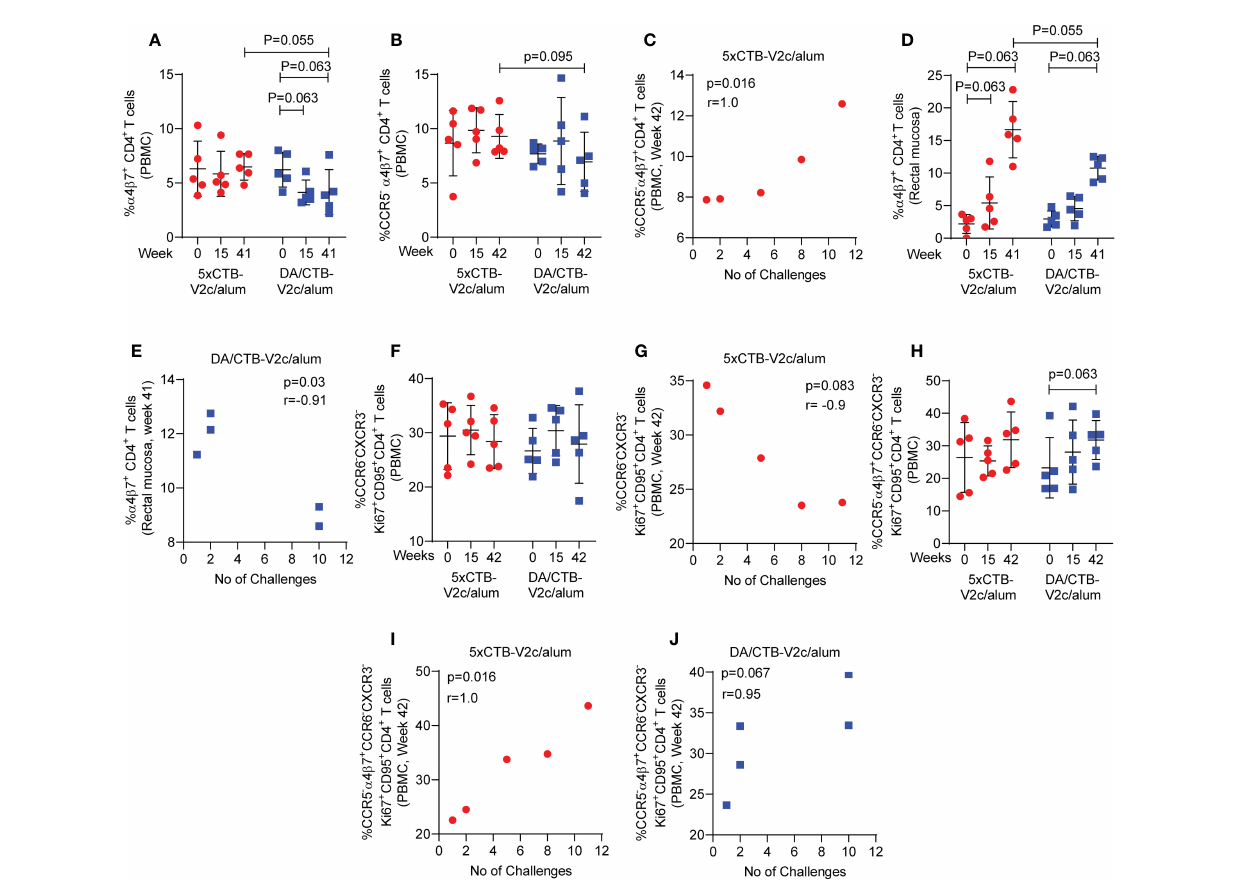
FIGURE 5 Comparison of different T cell subsets and their association with SIV acquisition. Comparison of the frequency of circulating (A) a 4 b 7+ CD4 + T cells and (B) CCR5 - a 4 b 7+ CD4 + T cells over the course of vaccination. (C) Correlation of circulating CCR5 - a 4 b 7+ CD4 + T cells with number of challenges in the 5xCTB-V2c/alum group. (D) Comparison of the frequency of mucosal a 4 b 7+ CD4 + T cells over the course of vaccination. (E) Correlation of mucosal a 4 b 7+ CD4 + T cells with number of challenges in DA/CTB-V2c/alum group. (F) Comparison of the frequency of circulating memory Th2 cells over the course of vaccination. (G) Correlation of circulating memory Th2 cells with number of challenges in 5xCTB-V2c/alum group. (H) Comparison of the frequency of circulating memory CCR5 - a 4 b 7+ Th2 cells over the course of vaccination. Correlation of circulating memory CCR5 - a 4 b 7+ Th2 cells with number of challenges in (I) 5xCTB-V2c/alum group and (J) in DA/CTB-V2c/alum group. Data shown in (A, B, D, F, H) were analyzed Mann-Whitney U test or Wilcoxon signed-rank test. Horizontal and vertical bars denote mean and SD, respectively. Data shown in (C, G, I, J) were analyzed with the Spearman correlation test. Data shown in (E) were analyzed with the Pearson ’ s correlation test. Red circles indicate 5xCTB-V2c/alum vaccinated macaque group, and blue squares indicate DA/CTB-V2c/alum vaccinated macaque